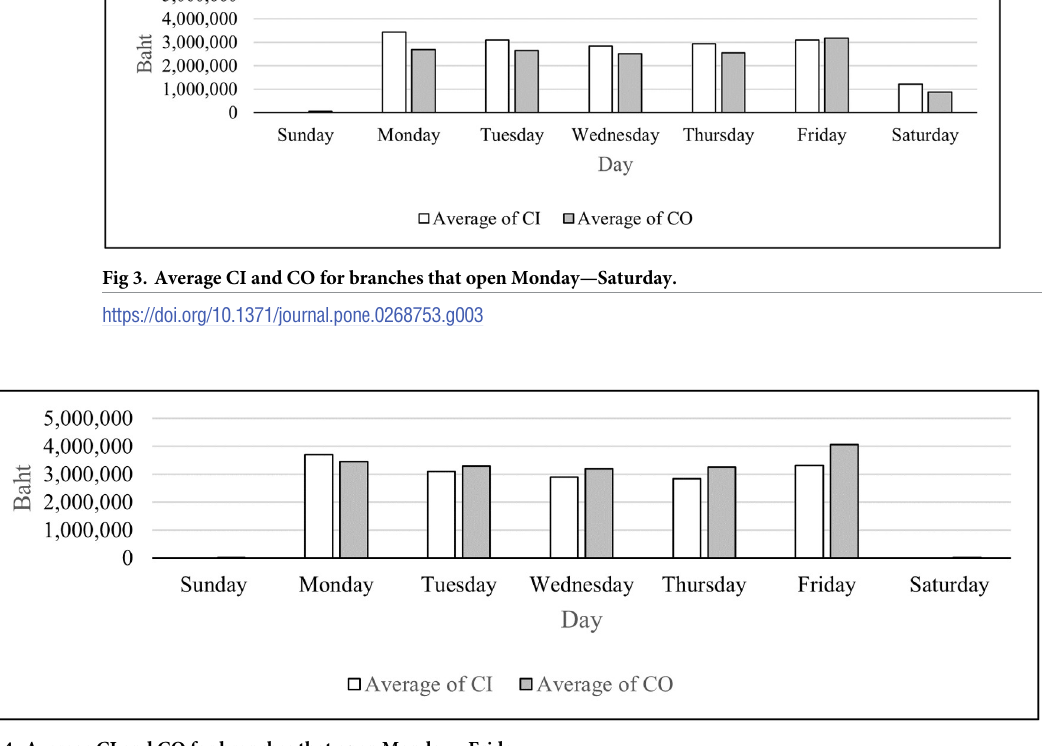
Fig 4. Average CI and CO for branches that open Monday—Friday.